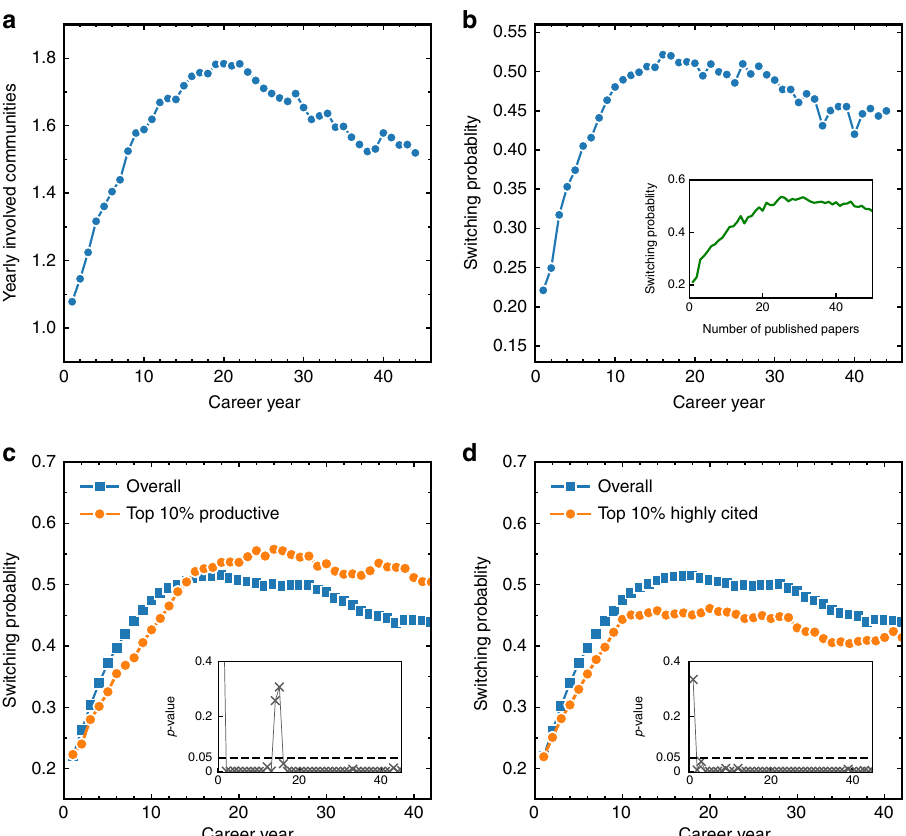
Fig. 3 Evolution of yearly involved communities and switching probability. a The mean number of yearly involved major communities for individual scientists in different career years. b The switching probability between two adjacent publications from one major community to another major community of scientists in different career years. The inset shows the switching probability as a function of the number of papers published in a career. c Comparison of the overall switching probability (all scientists) with the switching probability of the 10% most productive scientists in different career years. The results suggest that high productivity is associated with low switching probability in the early career, but with high switching probability in the later career. d Comparison of the overall switching probability (all scientists) with the switching probability of the 10% scientists who has the highest mean citation per paper. For each paper, we only consider the number of citations 10 years after its publication ( c 10 ) 13 . The results suggest that high average citation per paper in all career periods correlates with low switching probability. In the insets of ( c , d ), we present the p -value of the Kolmogorov – Smirnov